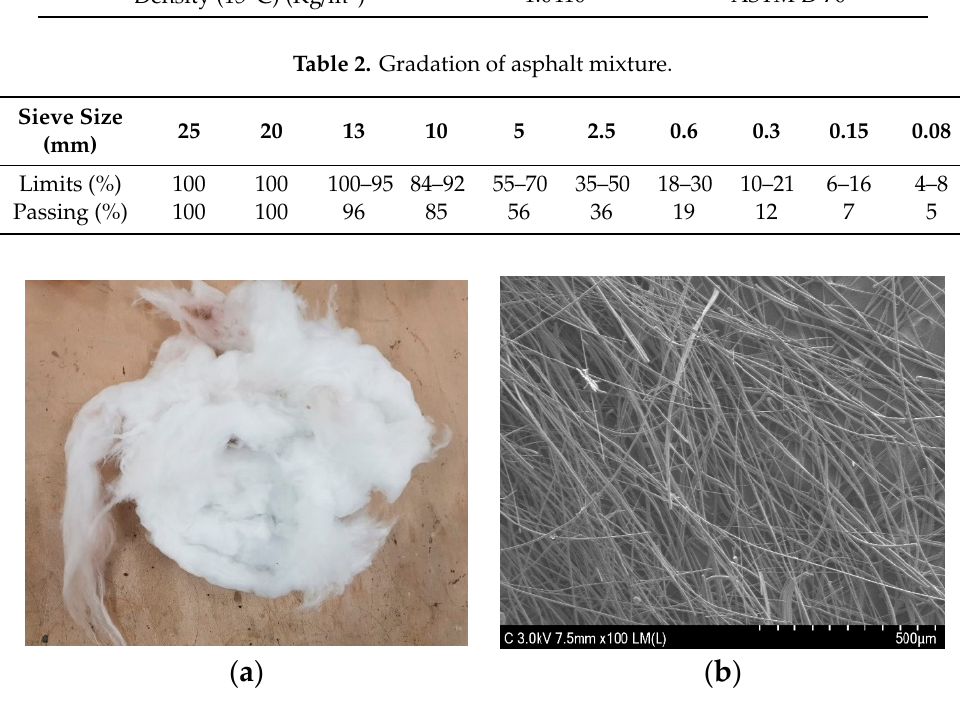
Table 2. Gradation of asphalt mixture .